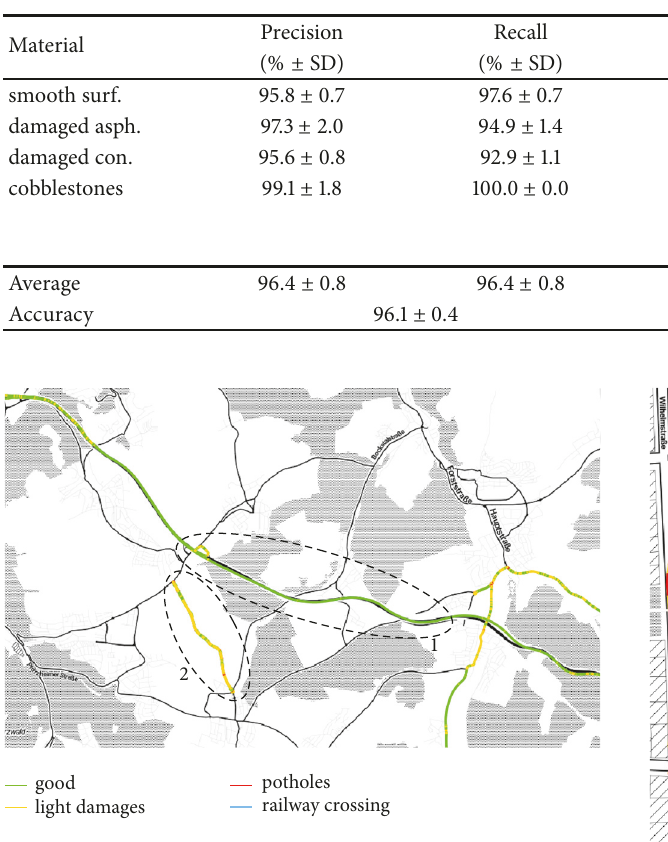
Figure 6: Event classification results of two high speed roads in the south west of Karlsruhe, Germany.